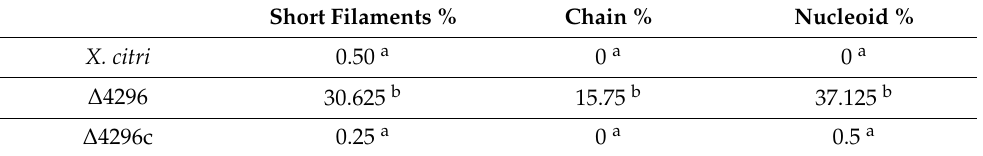
Table 2. Statistics of morphotypes and nucleoid distribution of cells cultivated in rich medium (NB). Short Filaments % Chain % Nucleoid %